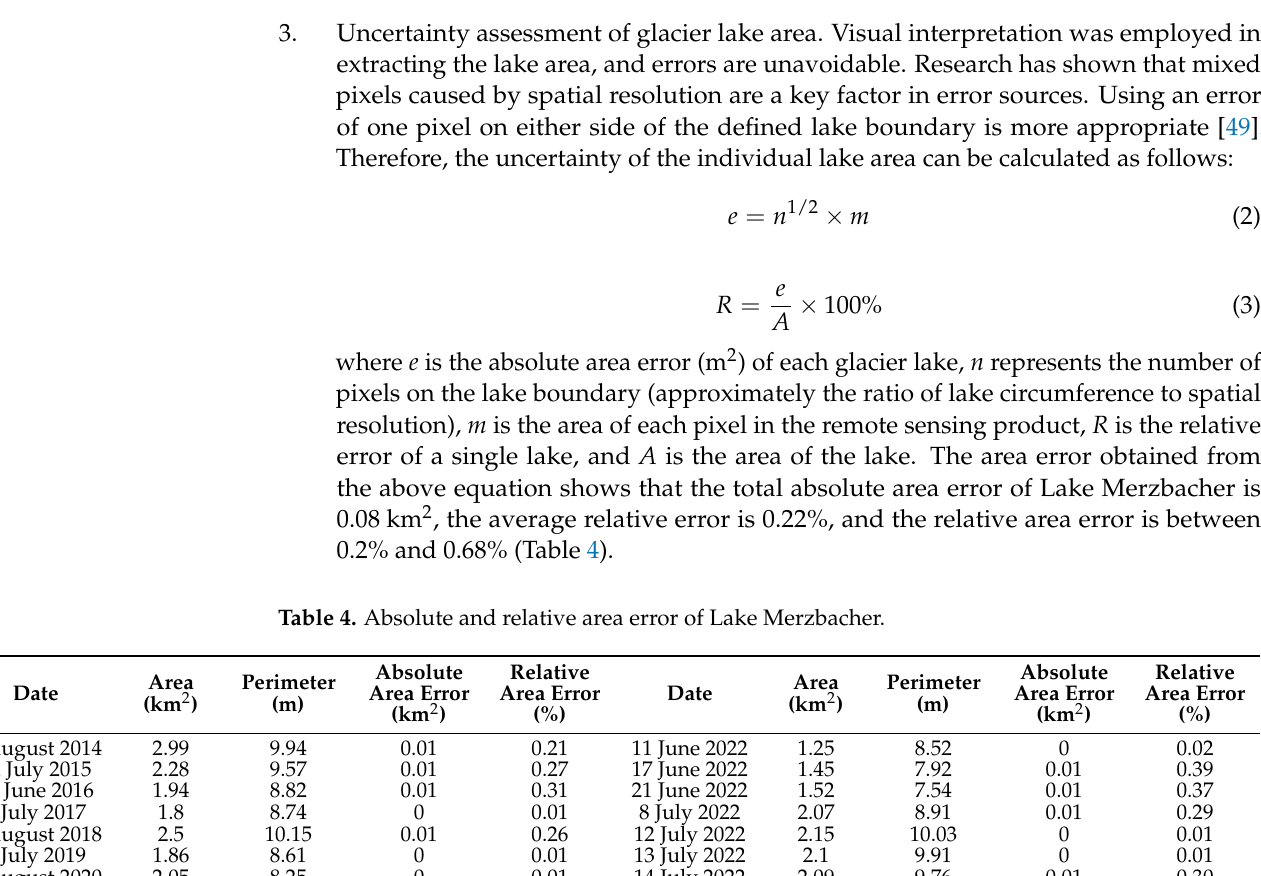
Figure 2. Satellite image ( a ) and image after calculating the NDWI ( b ).